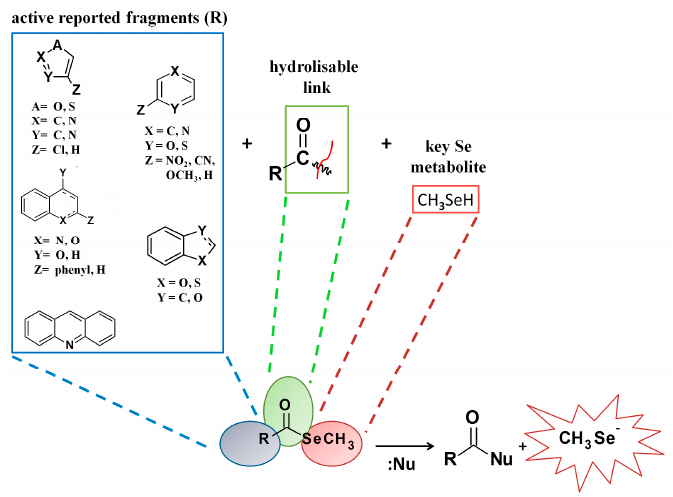
Figure 1. Fragment-based design of the novel methylselenoesters.